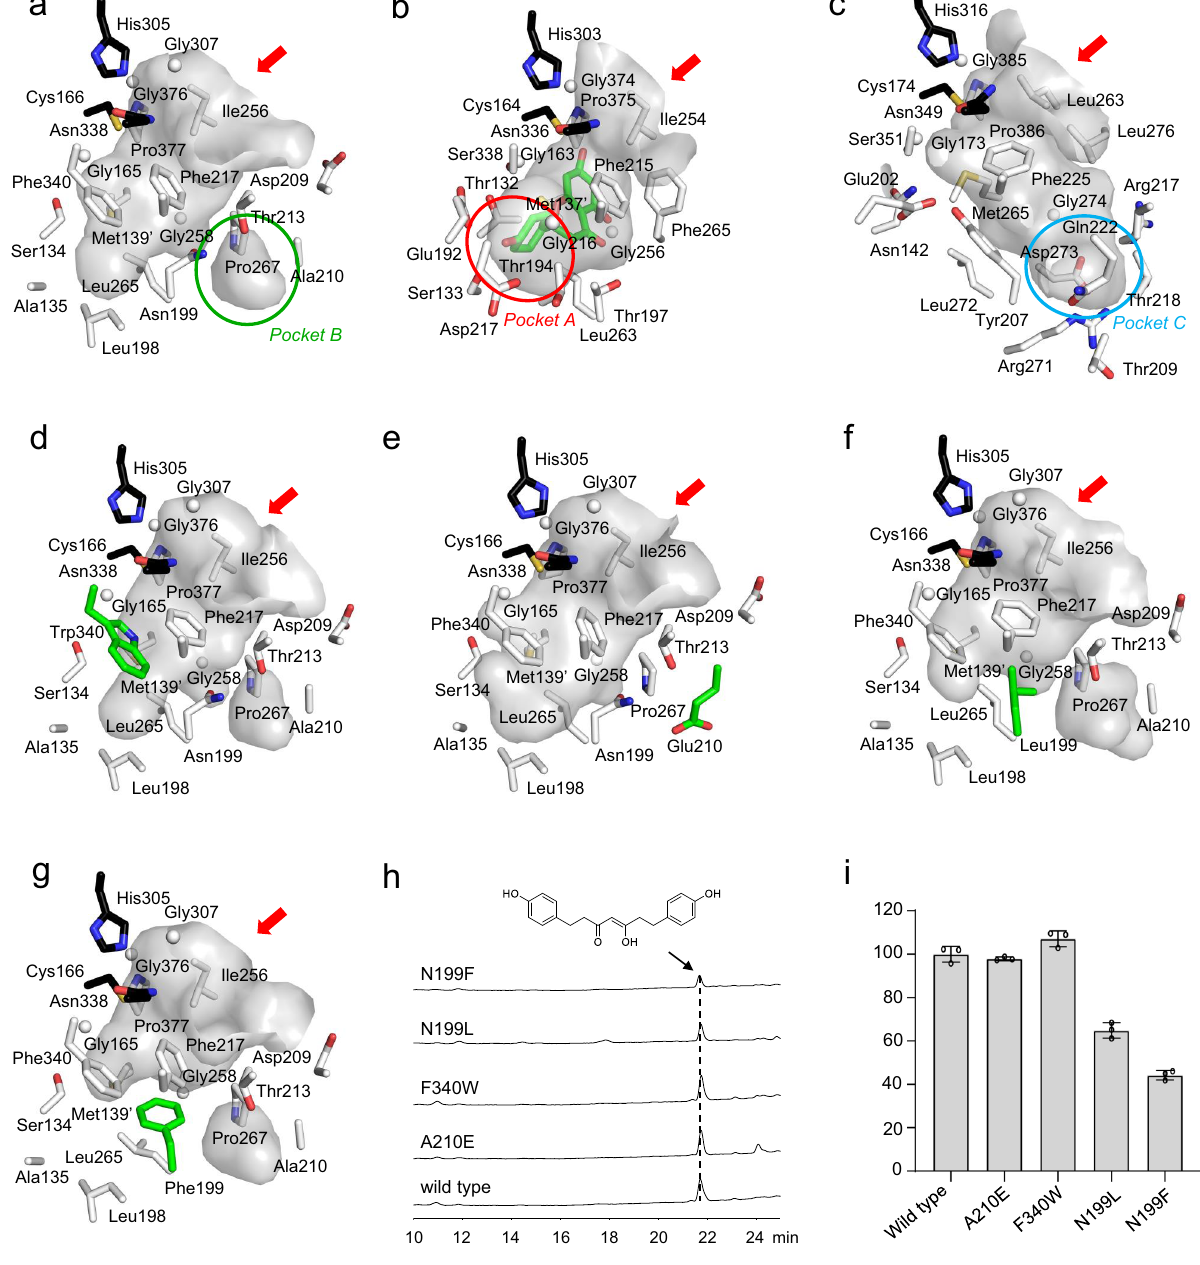
Fig. 4 Comparison of the active site topologies in the crystal structures and the activities of various PECPS mutants. a Wild type PECPS. b MsCHS. c CUS. d PECPS F340W. e PECPS A210E. f PECPS N199L. g PECPS N199F. h HPLC chromatograms of the products obtained from the enzymatic reactions of wild type PECPS and its mutants using 4-hydroxyphenylpropionyl-CoA and malonyl-CoA as substrates. Chromatograms were recorded at 295 nm. i Relative activities for the formation of tetrahydrobisdemethoxycurcumin ( 1 ) between wild type PECPS and its mutants. Activities are percentages of tetrahydrobisdemethoxycurcumin ( 1 ) production relative to that of wild type PECPS. Data represent the mean ± SD ( n = 3). PDB ID: a 7FFA. b 3ALE. c 1CGK. d 7FFI. e 7FFC. f 7FFH. g